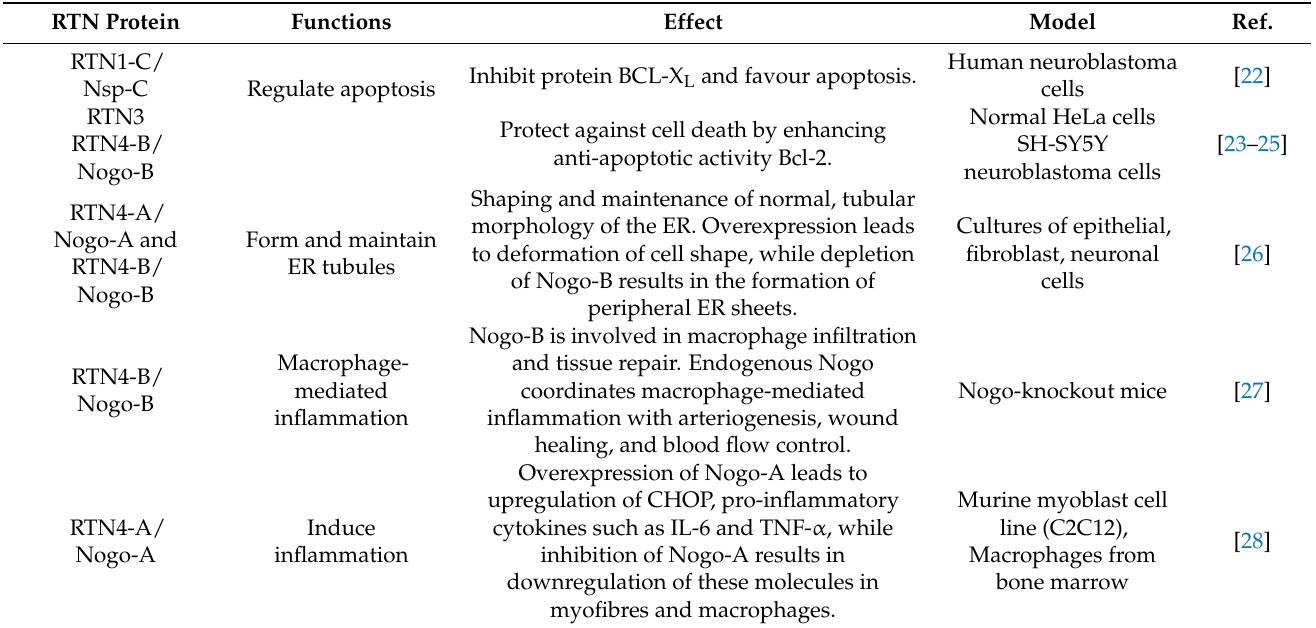
Table 2. Functions of RTNs in the nervous